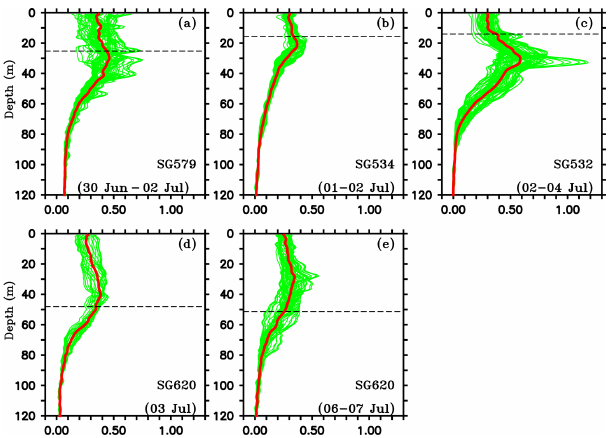
Figure 10. Vertical profiles of chlorophyll (mgm − 3 ) from ocean gliders during surface bloom events, as shown in Fig. 5. Individual profiles are given in green, and the corresponding mean profiles are given in red. Black dashed line represents the mixed layer depth, which is calculated as the depth where density is equal to the sea surface density plus an increase in density equivalent to a reduction in temperature of 0.8 ◦